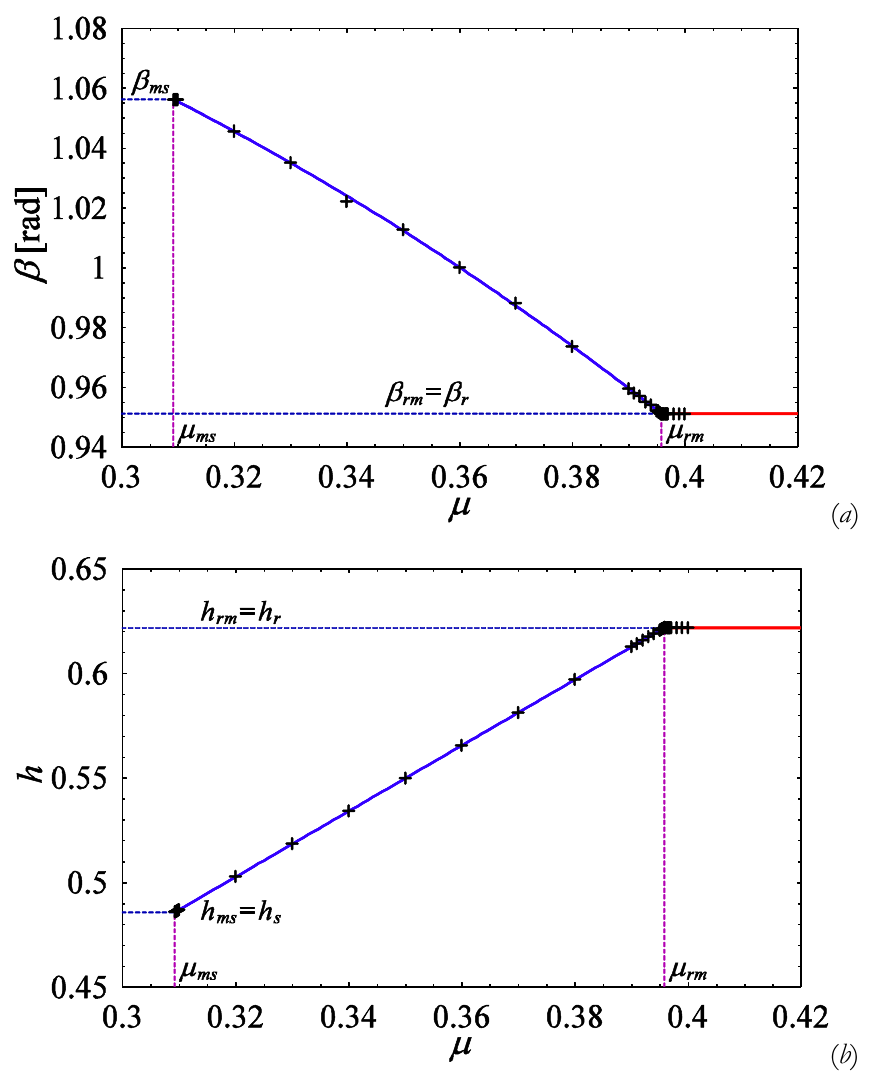
Figure 8: Trends of characteristic parameters  , h at variable friction coefficient  , obtained by the analytical and numerical analyses: (a) inner hinge angular position  ; (b) non-dimensional horizontal thrust h . Reducing friction  sets a non-linear increase of